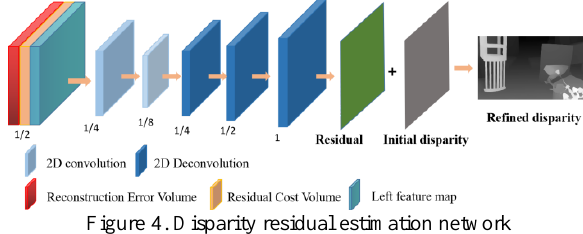
Figure 4. Disparity residual estimation